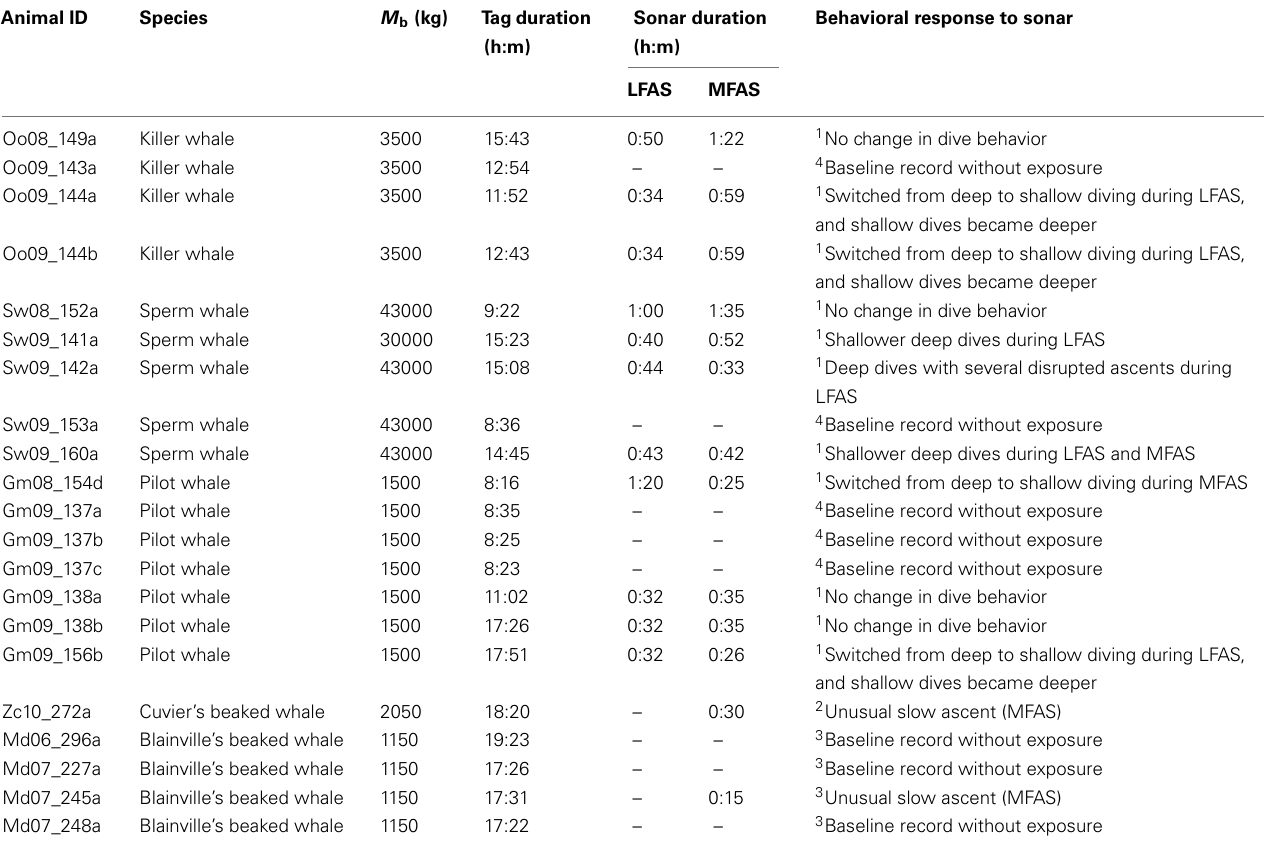
Table 1 |Animal ID, species, assumed body size ( M b ), total dive record duration, sonar exposure duration (LFAS and/or MFAS) and description of behavioral responses to sonar as reported by 1 Sivle et al. (submitted), 2 Southall et al. (2011), or 3 Tyack et al. (2011). In addition some baseline data records without sonar exposures are also included as reported by 3 Tyack et al. (2011) and 4 Miller et al.